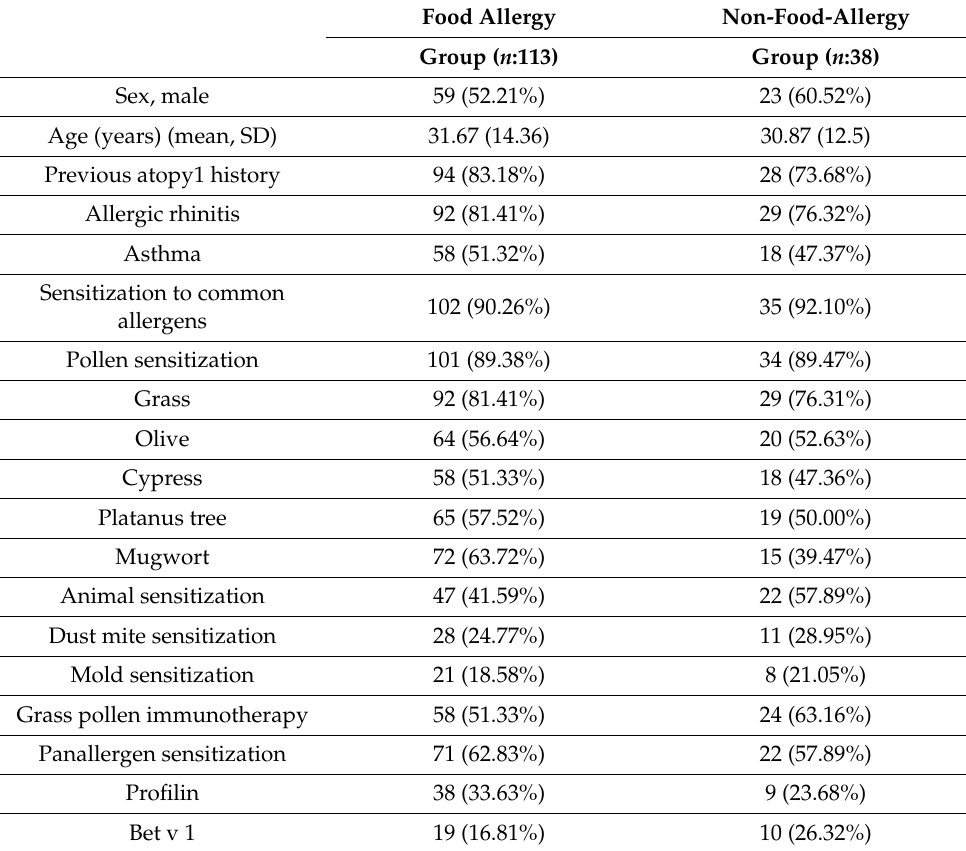
Table 1. Demographic and clinical characteristics of patients sensitized to nsLTP (baseline data).